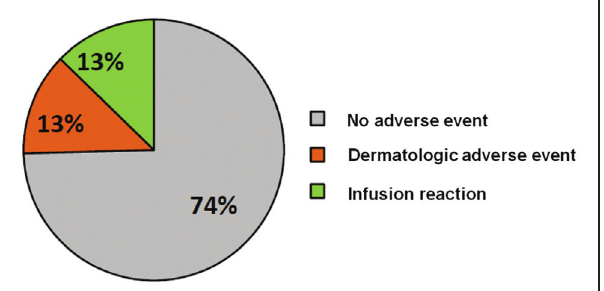
Figure 1) More than one-quarter of inflammatory bowel disease patients receiving stable maintenance infliximab therapy developed infliximab-associated adverse events TABle 2 Demographics of inflammatory bowel disease